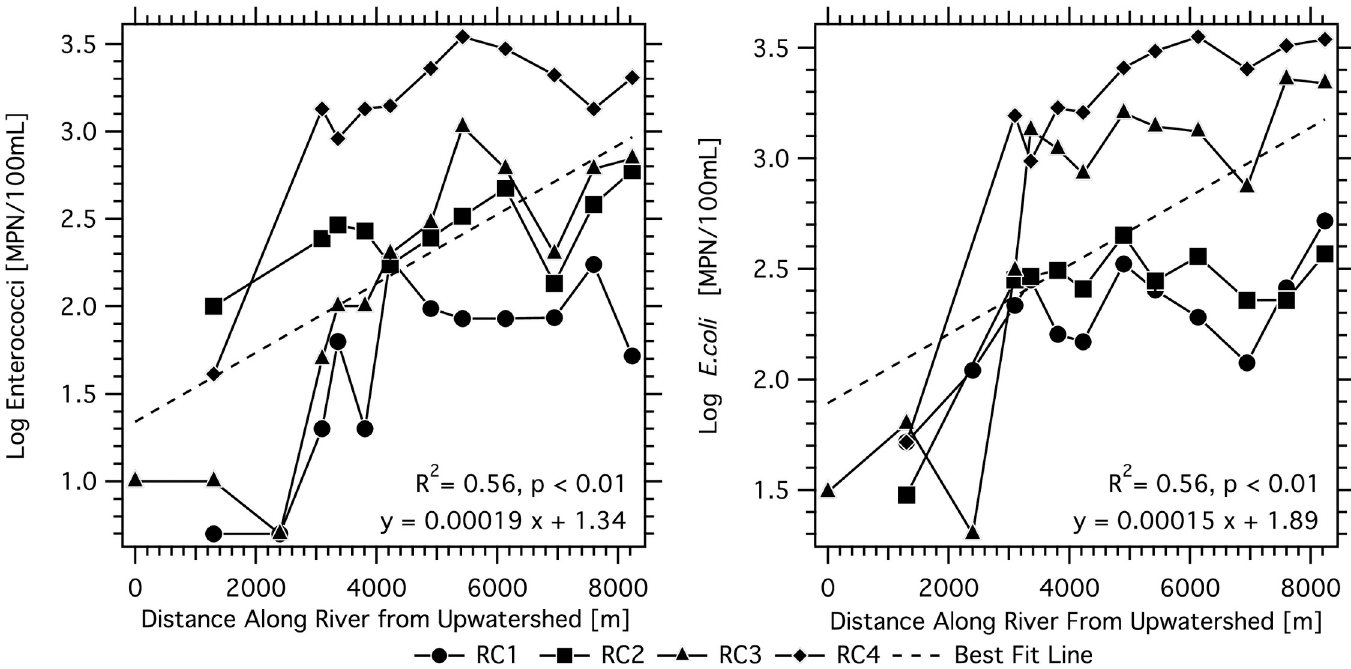
Fig 3. Log 10 mean concentrations of enterococci and E . coli in surface water as function of distance along the length of the Hanalei River from the river mouth. Dashed line represents linear regression of all water samples. The distance represents the along river distance from the USGS